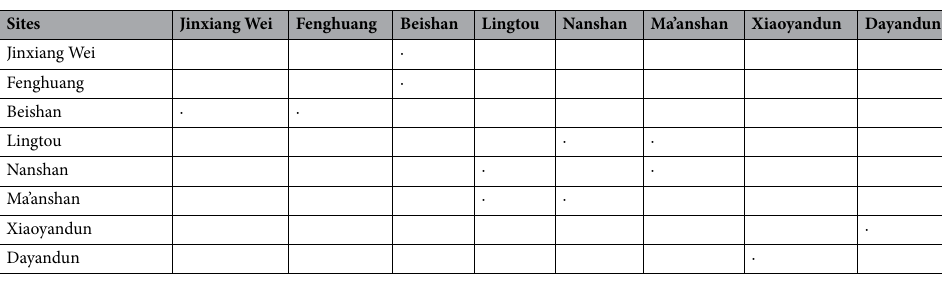
Table 5. Viewshed analysis results statistics of experimental sites. · means